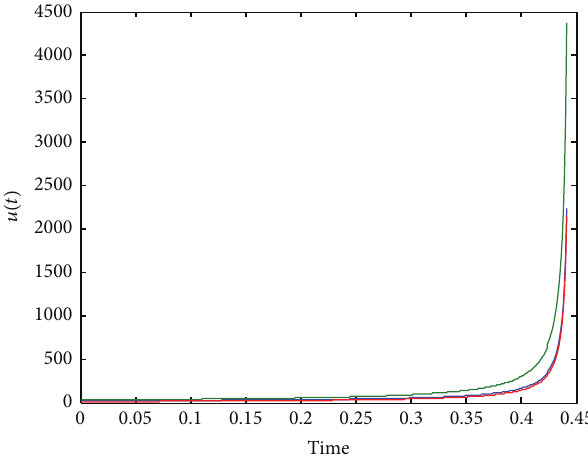
Figure 2: Behavior of each node for 𝑝 = 3 and 𝜆 = 1.1 .